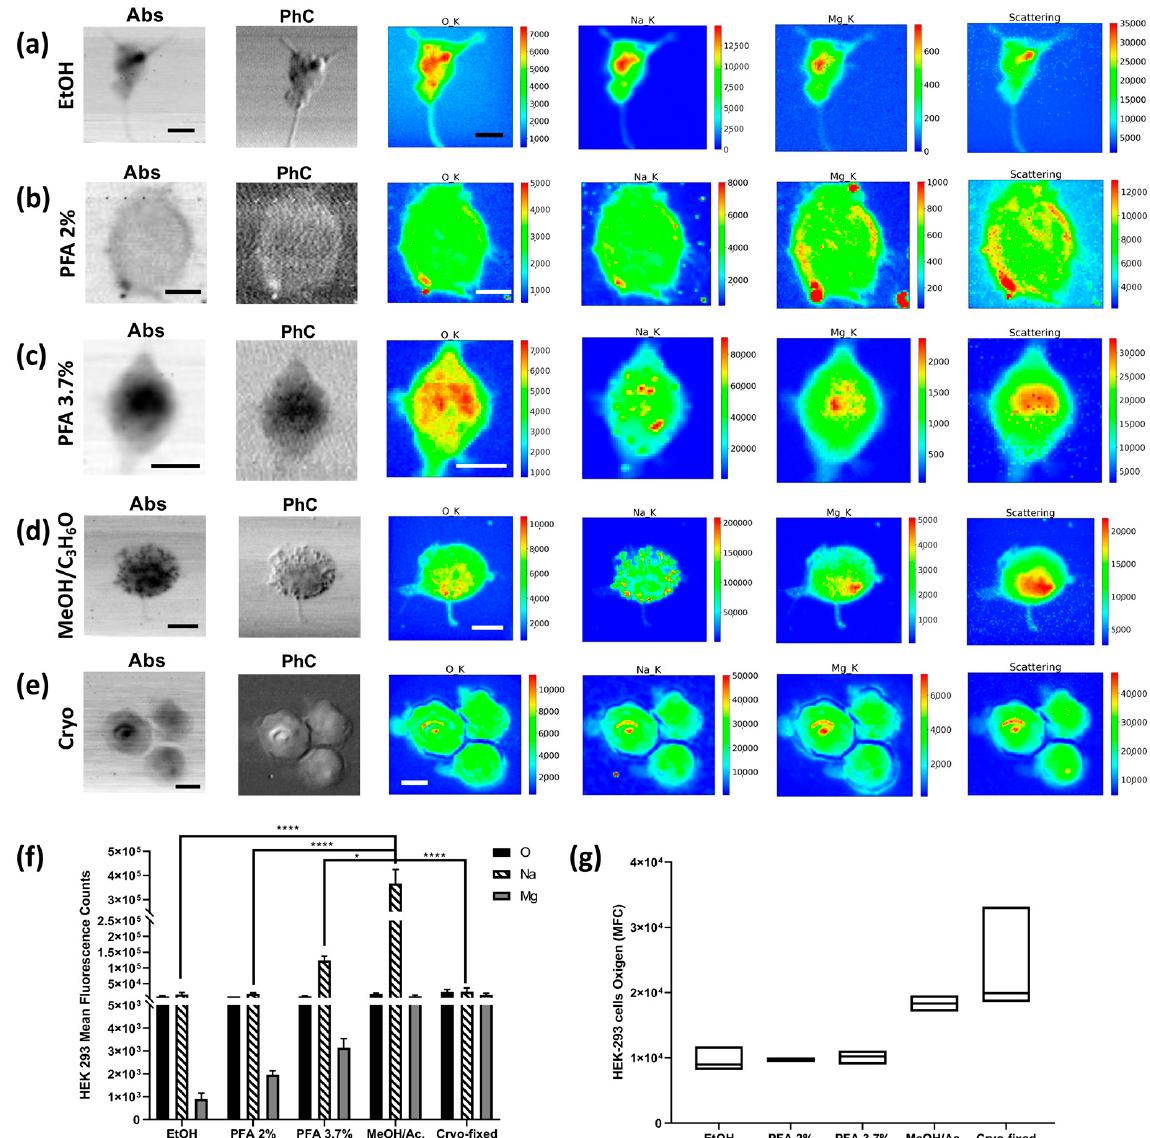
Figure 6. STXM and XRF analysis of HEK-293 cells. Absorption (Abs) and phase contrast (PhC) images, together with O, Na, Mg, and Scattering maps of HEK-293 cells fixed with different methods: ( a ) EtOH 70% (mapped area 45 × 45 μ m 2 ), ( b ) PFA 2% (mapped area 34 × 34 μ m 2 ), ( c ) PFA 3.7% (mapped area 25 × 30 μ m 2 ), ( d ) 1:1 MeOH/C 3 H 6 O (mapped area 40 × 40 μ m 2 ), and ( e ) cryofixed